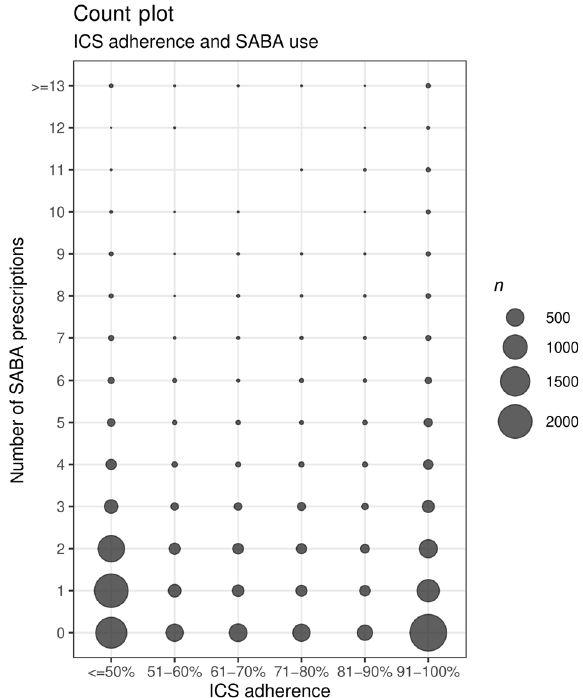
Fig. 4 Countplot in which the number of SABA prescriptions is shown per ICS adherence category for six